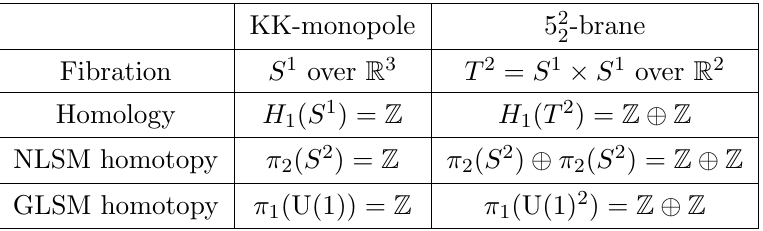
Table 2 . Related group structures of the instantons in NLSM and